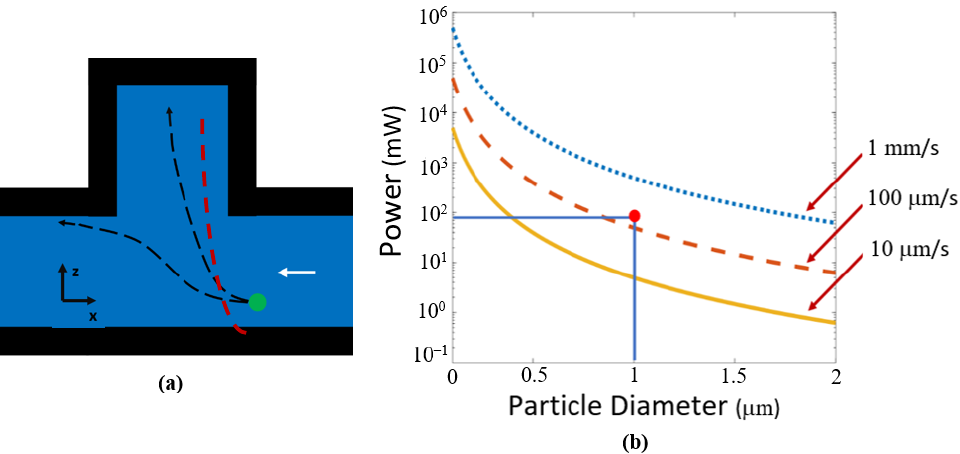
Figure 6. Orthogonal force design trapping characteristics. ( a ) Illustration of possible paths for a particle (green circle) passing a protrusion cavity showing a possible trapping event and an escape event demonstrated by the black dotted arrows. An approximate actual particle trajectory taken from Video S1 is shown by the red dotted line. The white arrow represents flow direction. ( b ) Optical trapping power needed to push particles into protrusion cavity, calculated for different particle sizes and fluid flow rates. The intersecting lines and dot on the plot demonstrate the power and particle diameter used experimentally.